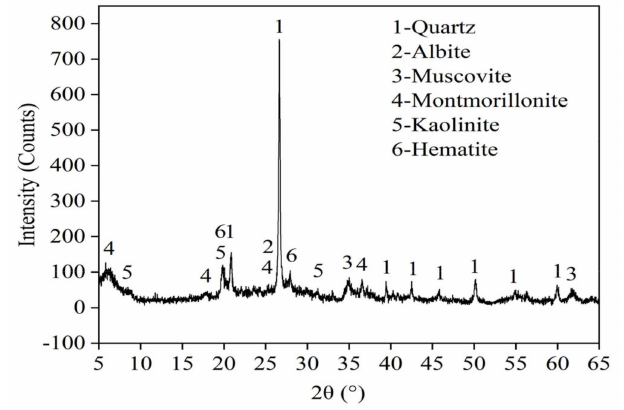
Figure 1. X − ray diffraction spectra of carbonaceous shale.